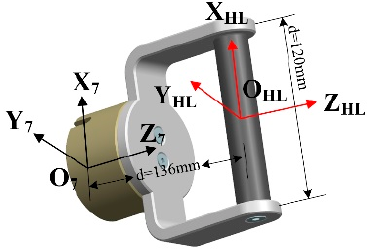
Figure 2. Three-dimension model of the handle.